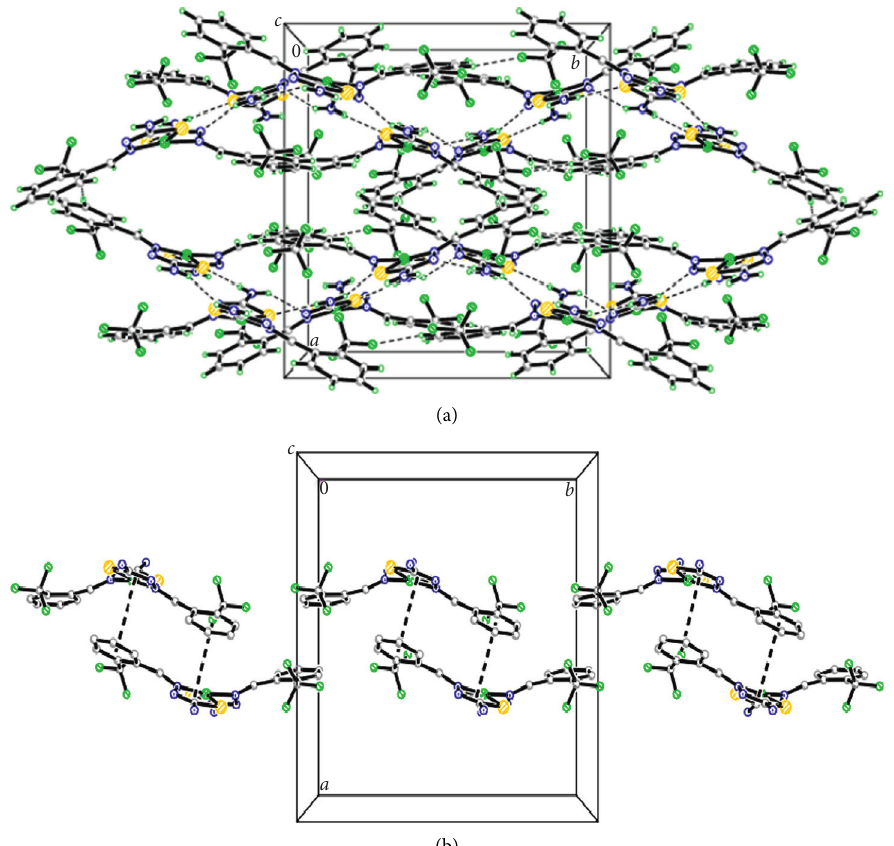
Figure 3: (a) Molecular packing diagram of NiL2 complex, showing molecules connected by intermolecular hydrogen bonds (dashed lines). (b) π–π interaction in NiL2 complex.